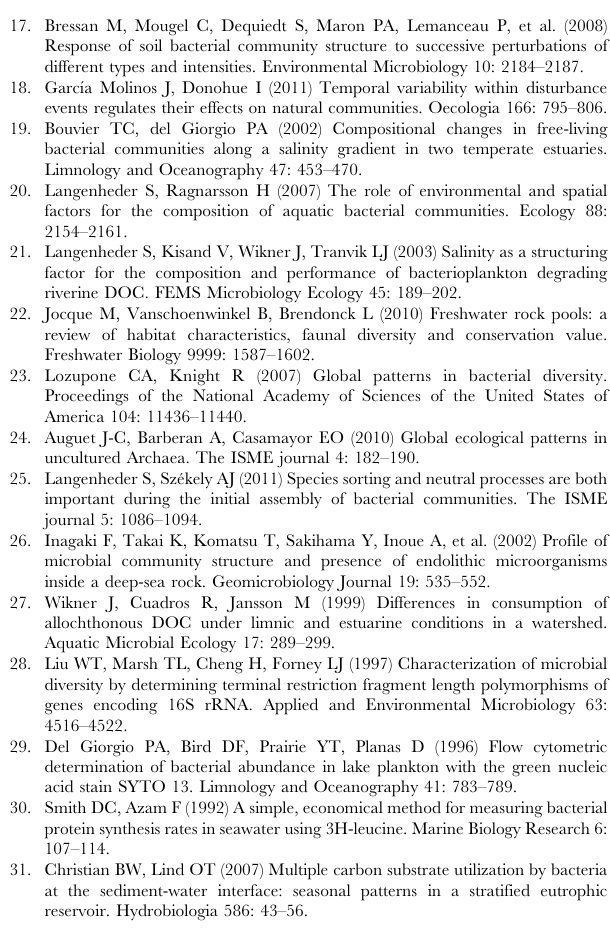
Table S1 Number of T-RFs. Presented is the average number of the TRFs 6 standard deviation, for each treatment, time point and